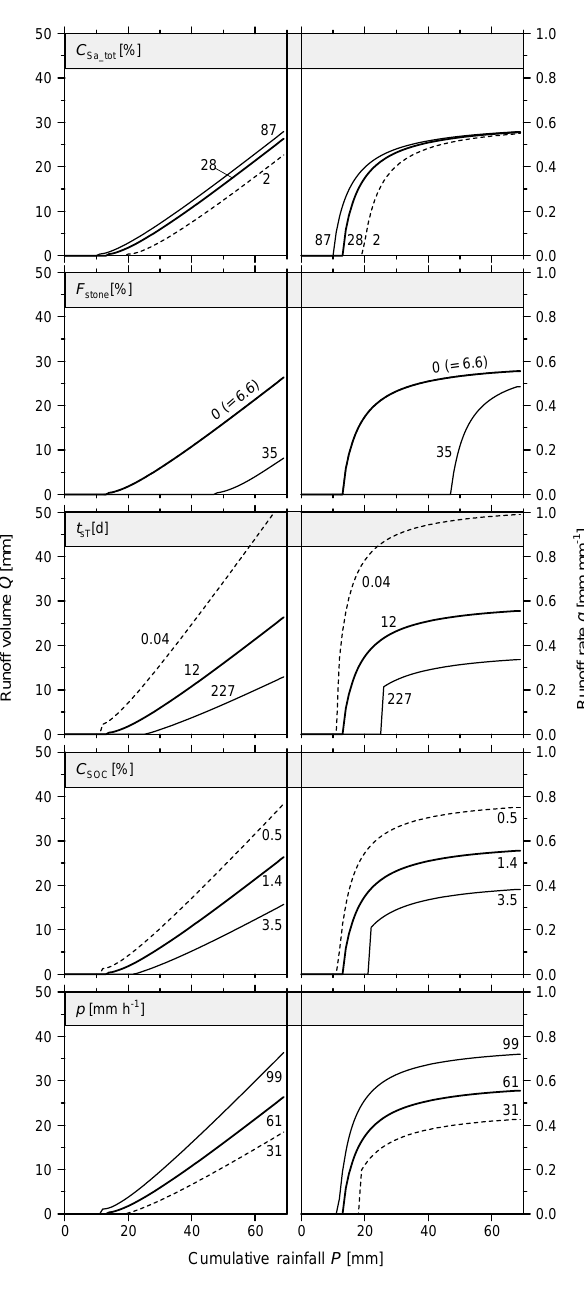
Fig. 4. Modelled accumulated runoff volume (left column) and in- stantaneous runoff rate (right column) for mean (bold line), min- imum (dotted line), and maximum (thin line) values of total sand content C Sa_tot , stone cover F stone , time since tillage t sT , soil or- ganic carbon content C SOC , and rainfall intensity p . Numbers de- note the minimum, mean and maximum of each variable. All vari- ables were kept constant at their mean value except the one varied. For F stone the minimum and the mean result in the same hydrograph as stone cover becomes active only for F stone > 10%